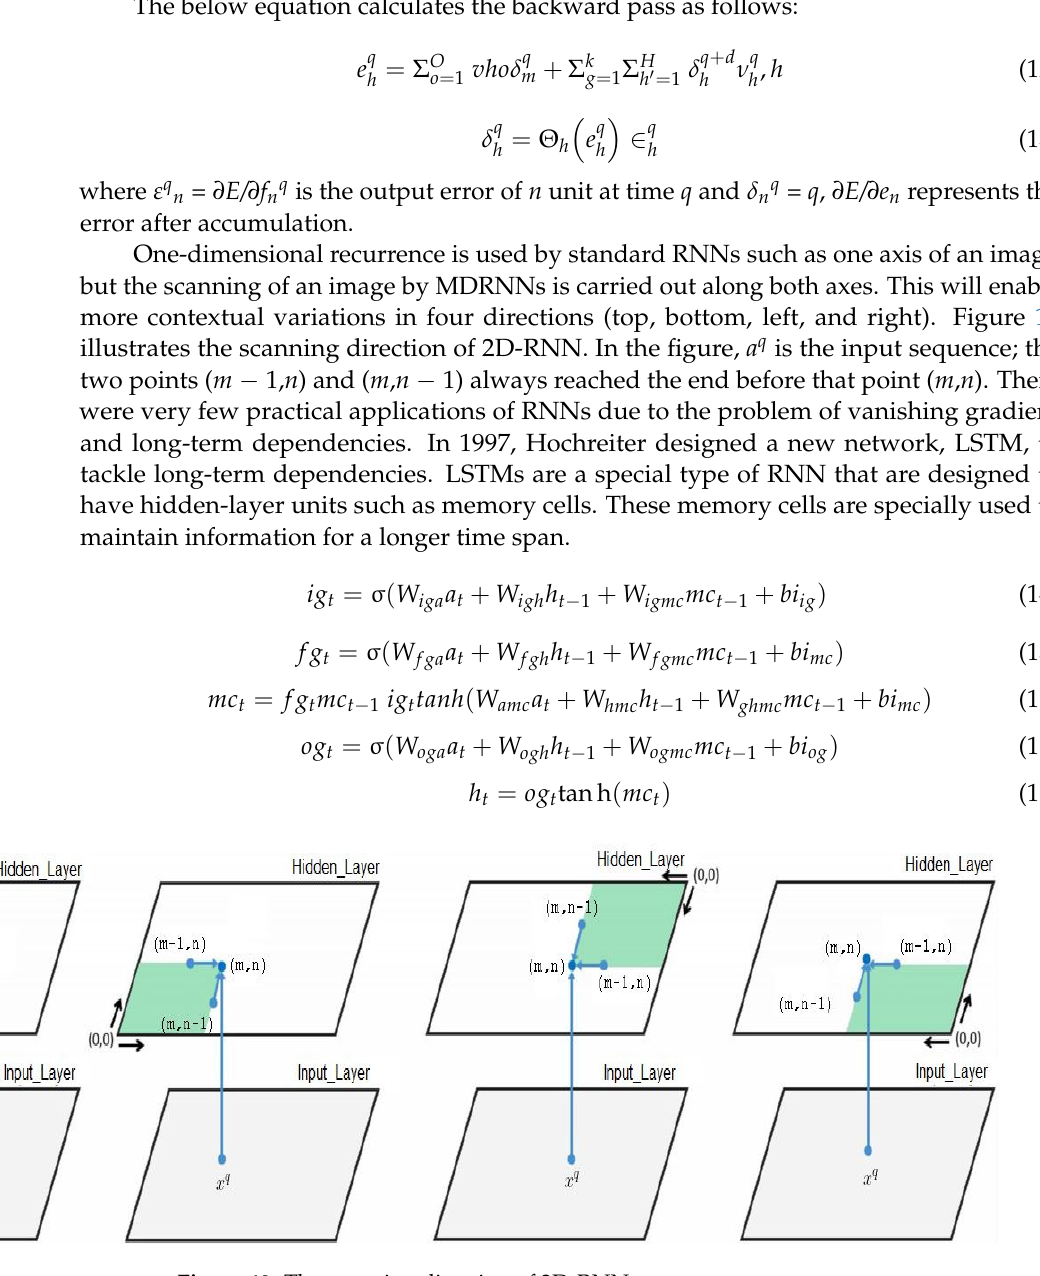
Figure 12. The scanning direction of 2D-RNN.